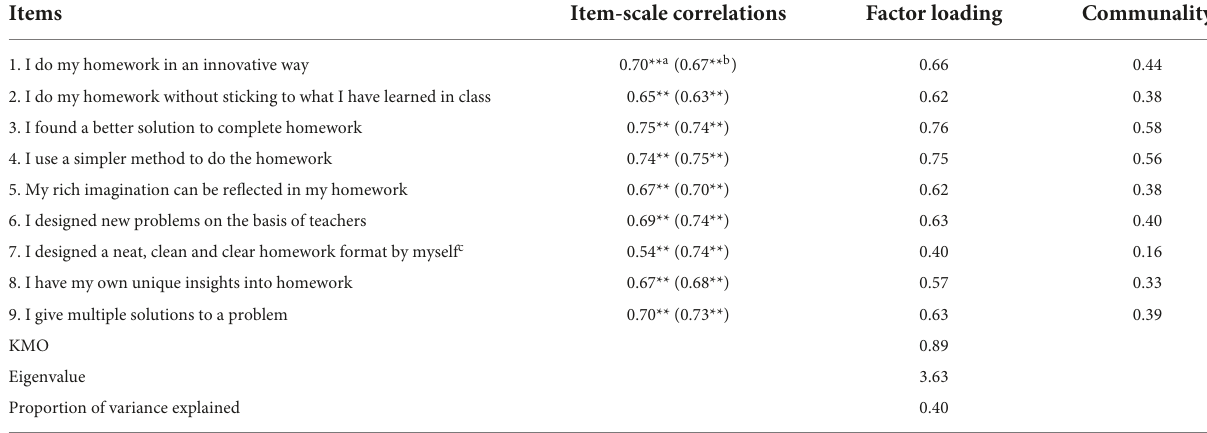
TABLE 2 Results of item discrimination analysis and exploratory factor analysis.